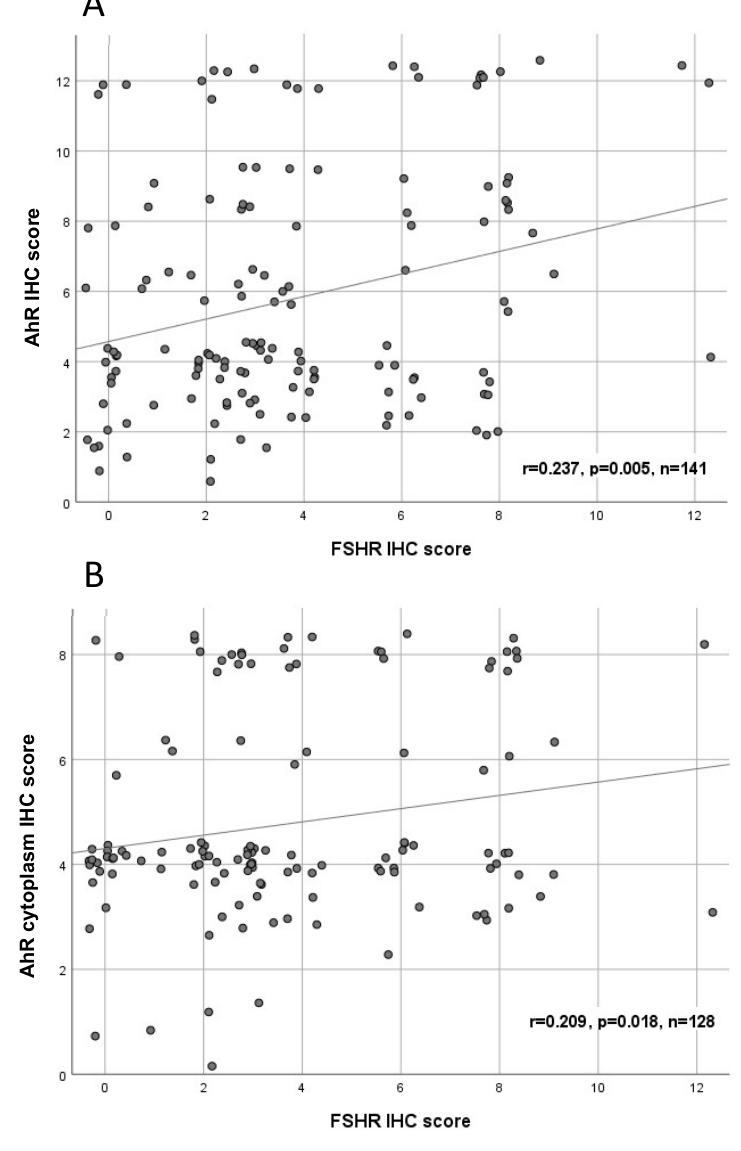
Figure 3. Correlation analysis of AhR ( A ) / cytoplasmic AhR ( B ) and FSHR in ovarian cancer tissue ( n = 141 / 128). A significant correlation of cytoplasmic AhR / AhR cytoplasm expression with FSHR expression was noted. For better visualization, dots have been jittered.